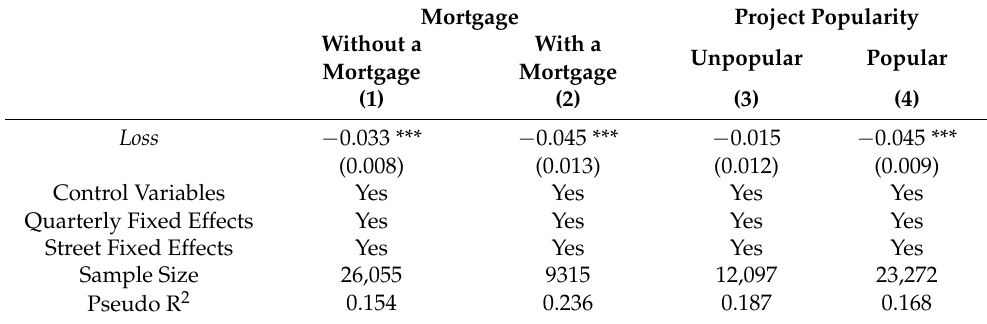
Table 10. Heterogeneity